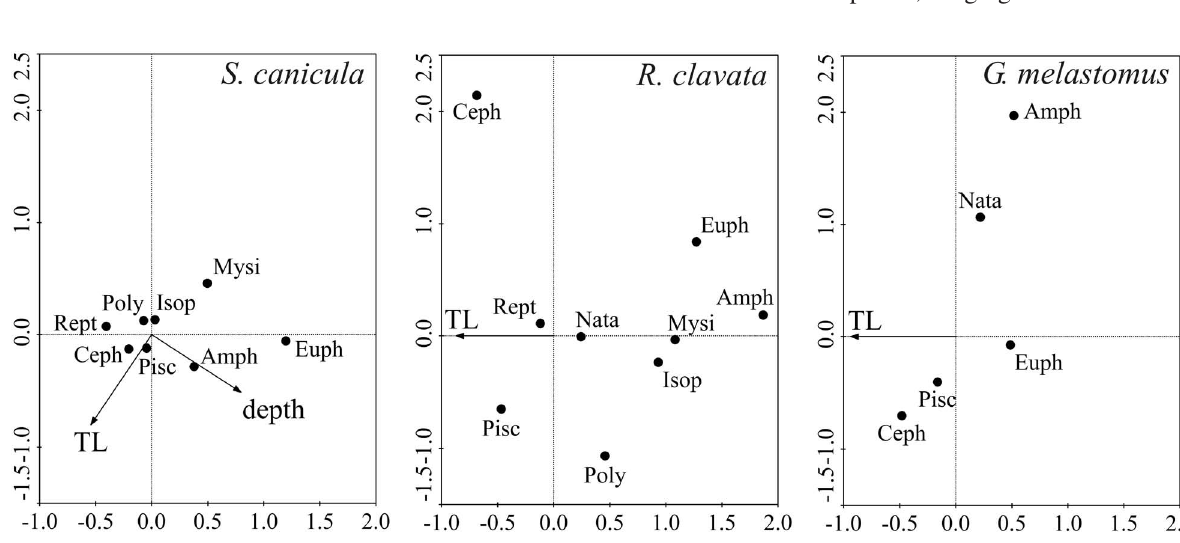
Fig . 2. – Partial canonical correspondence analysis (pCCA) biplots of the explanatory variables predator size (total length, cm) and depth of capture (in m) and nine different prey categories for the sharks Scyliorhinus canicula and Galeus melastomus and the skate Raja clavata . Euph, euphausiids; Amph, amphipods; Mysi, mysids; Isop, isopods; Poly, polychaetes; Nata, natantia; Rept, reptantia; Ceph, cephalopods; Pisc,